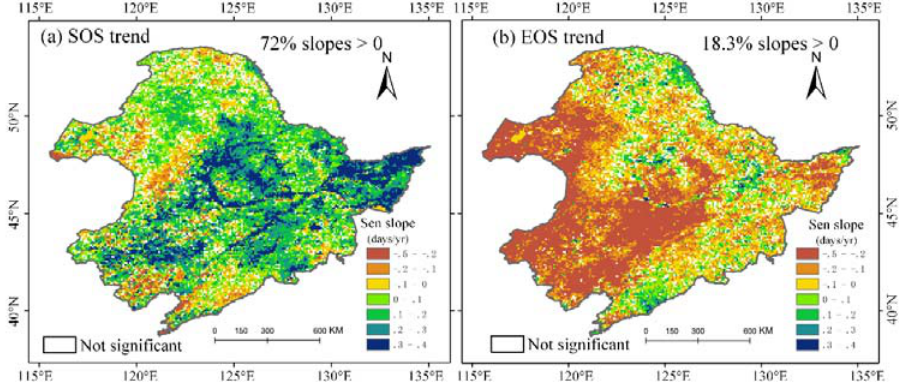
Figure 5. Spatial distribution of long-term trends for SOS and EOS (unit: days / yr, significance level: p value < 0.05). ( a ) map of SOS trend, ( b ) map of EOS trend.